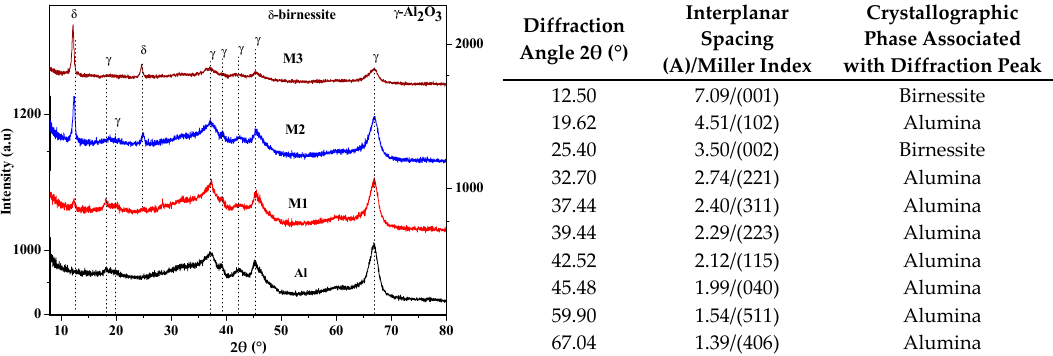
Figure 2. X-ray di ff raction patterns of alumina and supported materials. In the table is shown the Miller index of the identified crystallographic phases. The di ff ractograms show an increase in intensity and a decrease in the width of the di ff raction peak associated with birnessite, which suggests an increase in the crystal size of the active phase.